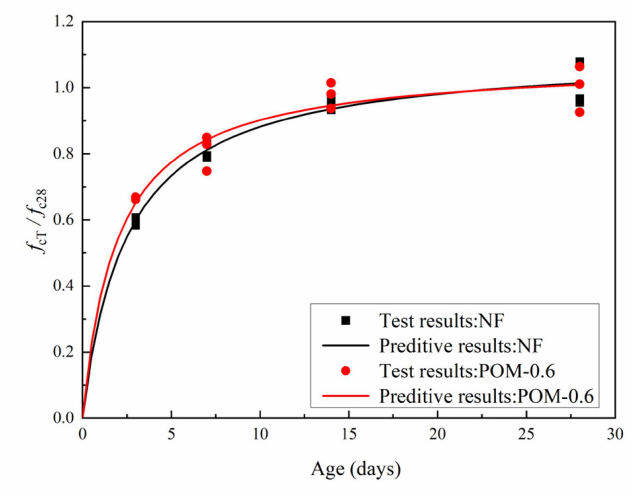
Figure 10. Relations between f cT / f c28 and concrete